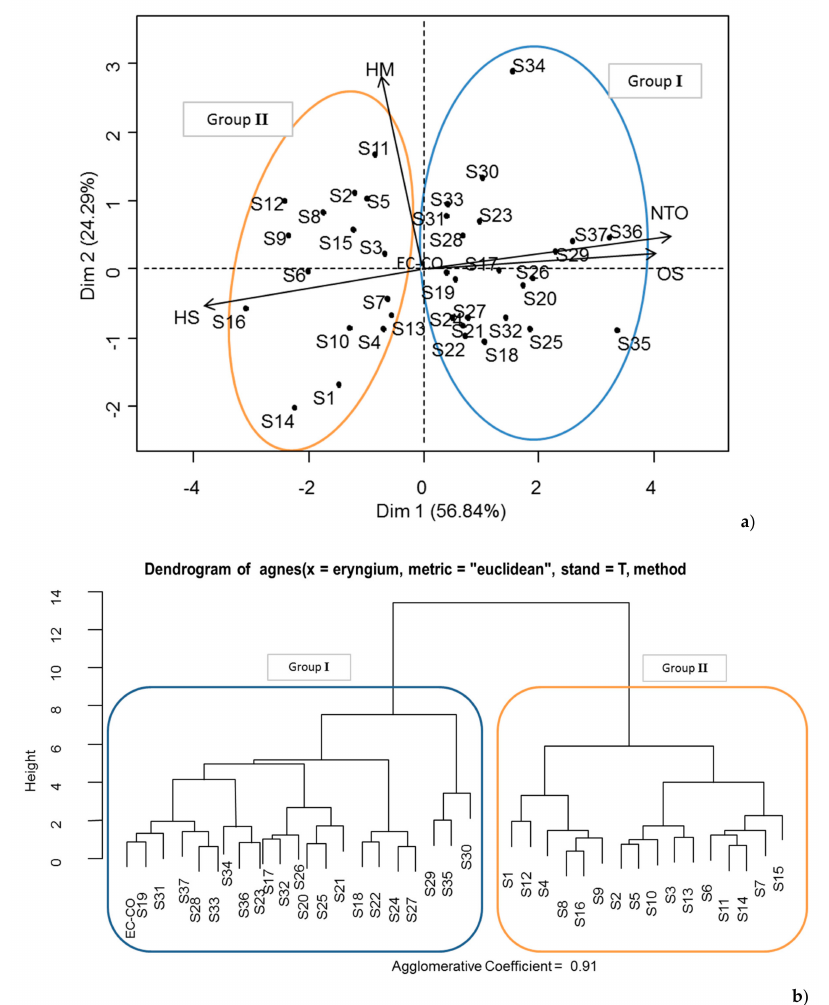
Figure 3. ( a ) Individual factors map obtained by principal component analysis performed on the oxygenated and hydrocarbon components of the 37 Algerian Eryngium campestre essential oil samples. Oxygenated compounds: (OS: Oxygenated Sesquiterpenes and NTO: Non Terpenic Oxygenated); Hydrocarbons compounds: (HM: Hydrocarbonated Monoterpenes and HS: Hydrocarbonated Sesquiterpenes). For more details on Samples S1–S37, cf. Supplementary Materials. ( b ) Dendrogram obtained using cluster analysis of chemical compositions of E. campestre essential oils from